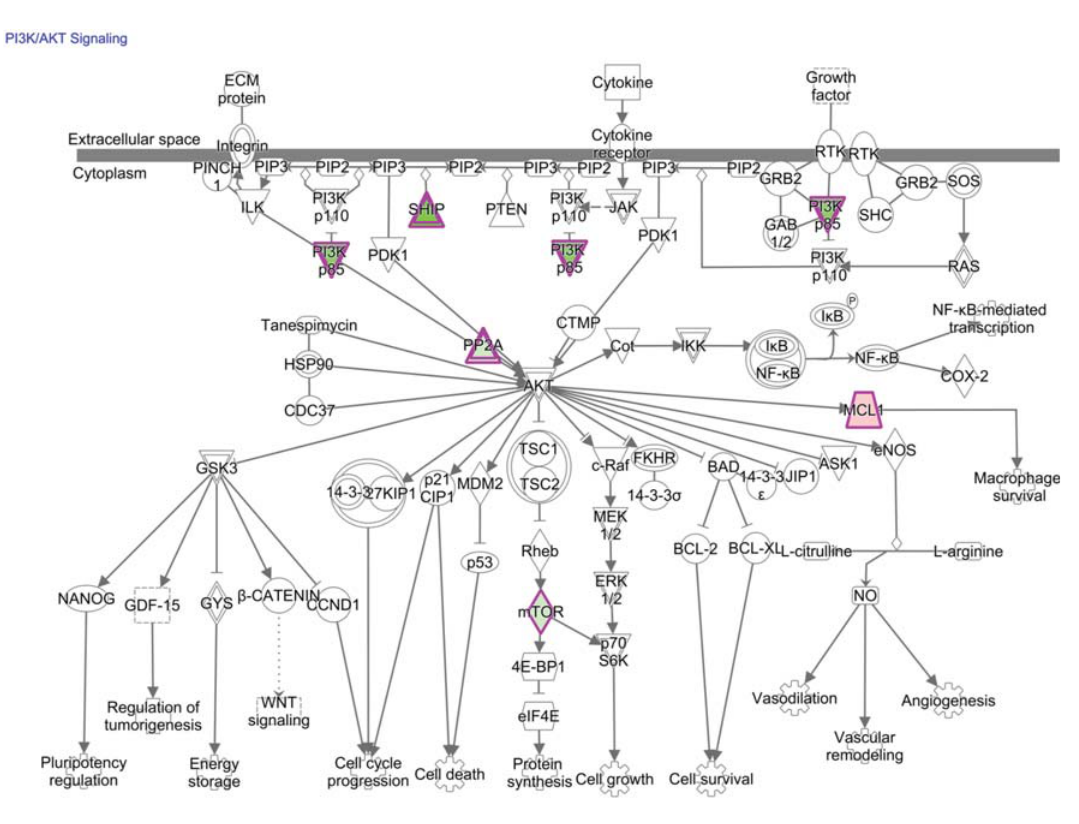
Figure 5. Many signals overlap with PI3K/AKT/mTOR pathways in tumor-specific CD8+ T cells. PI3K/AKT signaling is a canonical pathway enriched for molecules corresponding to differentially expressed genes of tumor-specific CD8+ T cells from the tumor relative to the periphery ( p -value = 4.1E-2, right-tailed Fisher Exact Test). These molecules are outlined in purple with red fill representing overexpression and green fill representing decreased expression in T cells from the tumor relative to the periphery; color intensity corresponds to the extent of expression difference. mTOR (or FRAP1) was previously published as being down-regulated in TIL and was predicted by our analysis to be an upstream regulator of differential gene expression (fold-change = (cid:4)3.1, and p -value of overlap = 2E-2, right-tailed Fisher Exact Test). Differentially-expressed genes and corresponding fold-changes have been previously published and were reanalyzed through the use of QIAGEN’s Ingenuity ® Pathway Analysis (IPA ® , QIAGEN Redwood City, www.qiagen.com/ingenuity) [35]. Both direct and indirect relationships were assessed in the Ingenuity knowledge base reference set with a confidence threshold of previous experimental observation in T